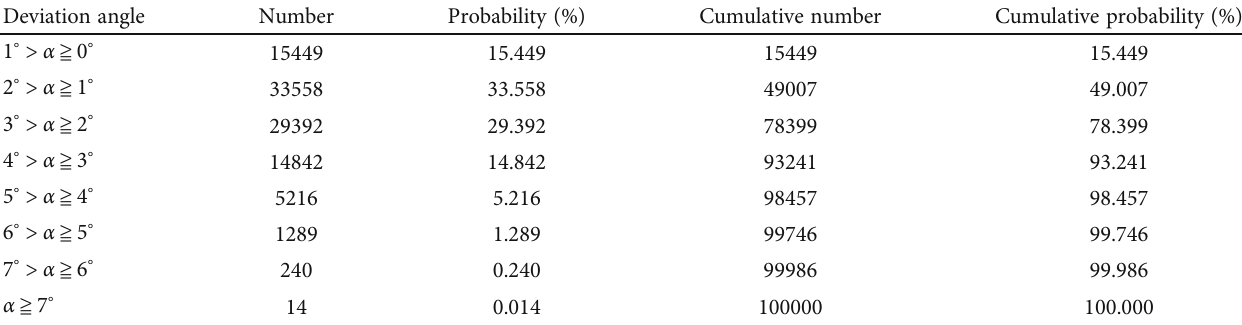
Table 2: statistical analysis results of the available navigation star deviation from the optimal navigation star.